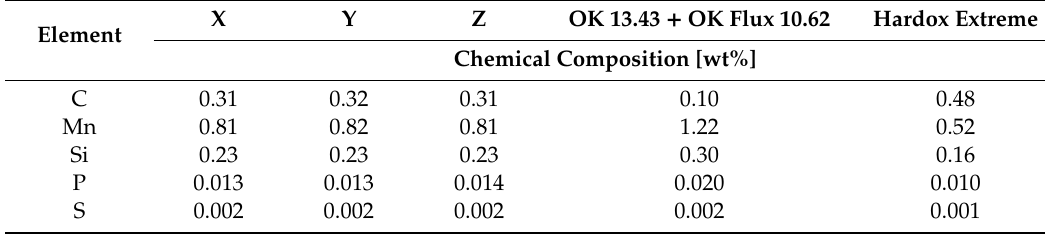
Figure 4. Ultimate tensile strength R m of tested samples based on data from Table 5. Table 6. Chemical composition in cross-section of the welded joint.